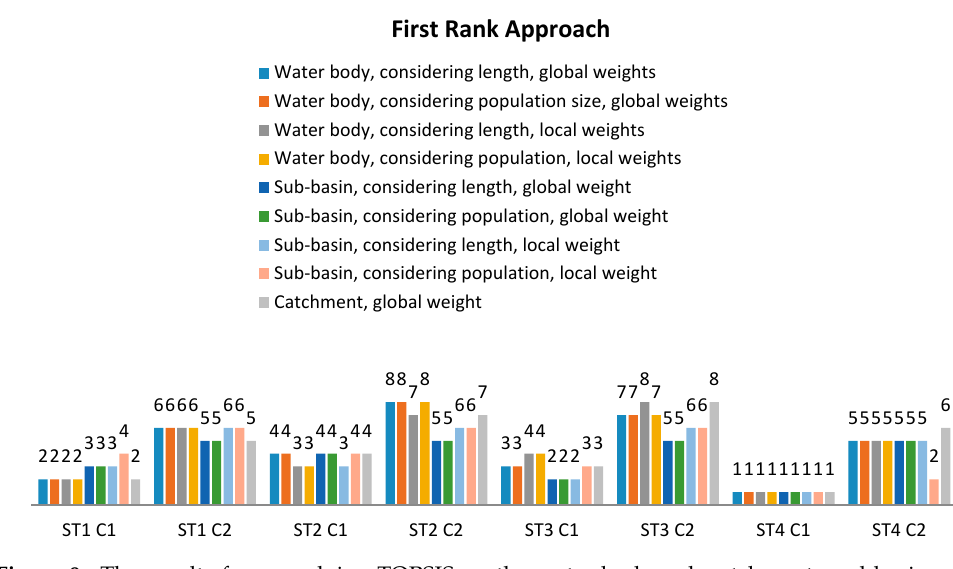
Figure 9. The results from applying TOPSIS on the water body, sub-catchment, and basin scales for the different decision inputs we consider. The final rank results obtained at the water body and sub-catchment scale are aggregated using the first rank approach.